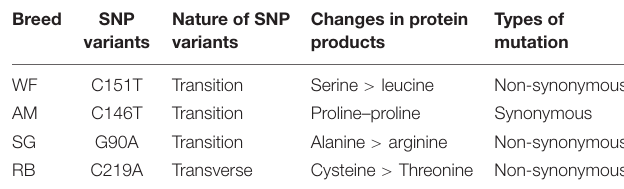
TABLE 5 | Characteristics of SNP variants identified in the present